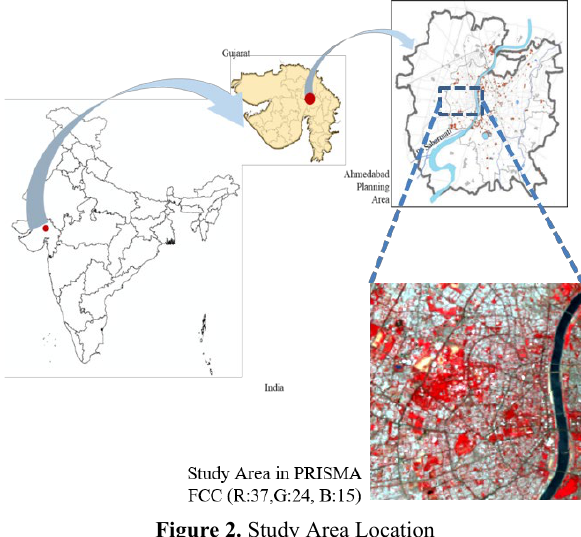
Figure 2. Study Area Location